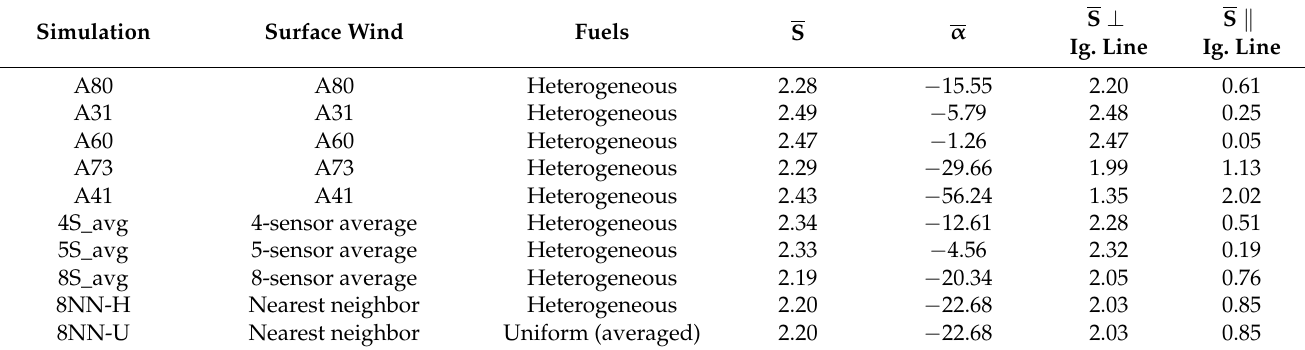
Table 2. Input parameters for the 10 FIRETEC simulations of the S5